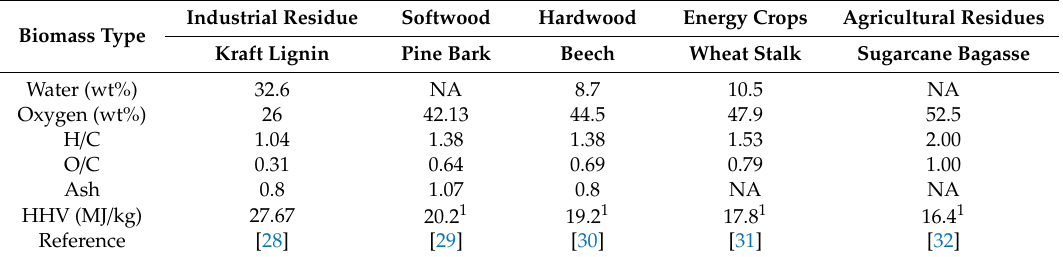
Table 2. Examples of lignocellulosic biomass, studied for bio-oil production, and their properties. Elemental composition, ash, and higher heating value (HHV) are reported on a water-free basis. Water content is also reported when